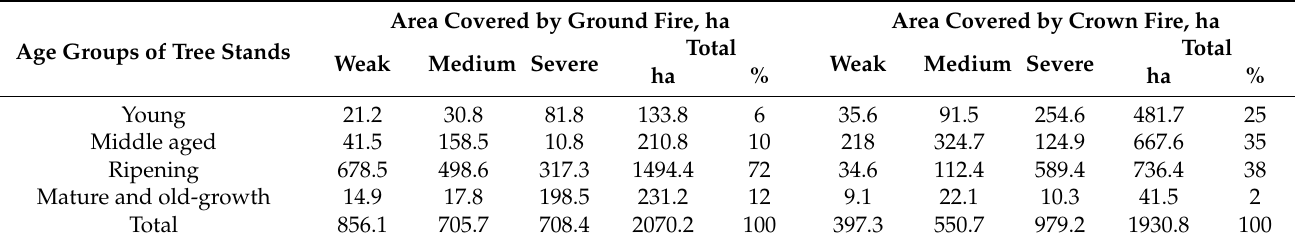
Table 3. Distribution by age groups of forest areas covered by fires of various intensity.